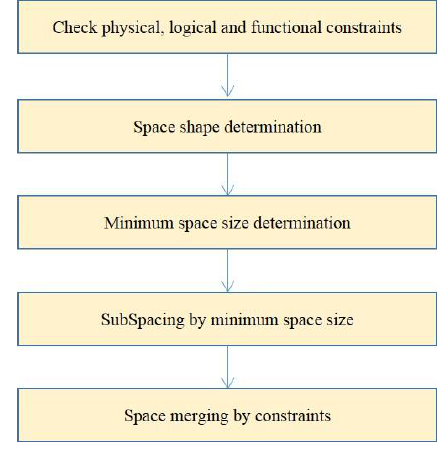
Figure 1. Process of